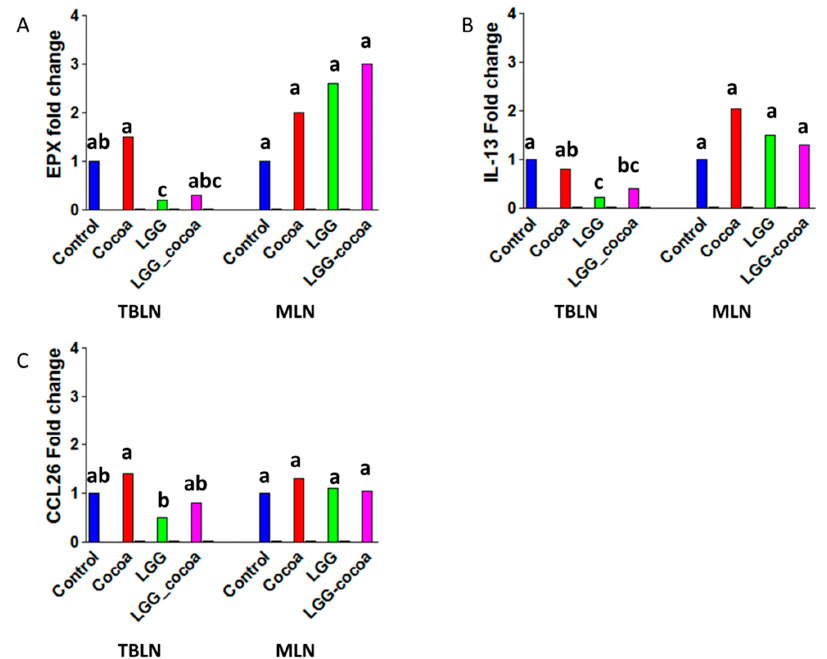
Figure 3. Gene expression related to a type-2 immune response in Tracheobronchial lymph nodes (TBLNs) and Mesenteric Lymph nodes (MLNs). Gene expression in TBLNs and MLNs were measured by RT-PCR ( n = 8/group): ( A ) EPX (Eosinophil peroxidase); ( B ) IL-13 (interleukin 13); and ( C ) CCL26 (C-C motif ligand 26). Bars represent a mean fold change. The control group was designated as one-fold change. Labeled means without a common superscript letter differ ( p < 0.05). Nutrients 2017 , 9 , 1113